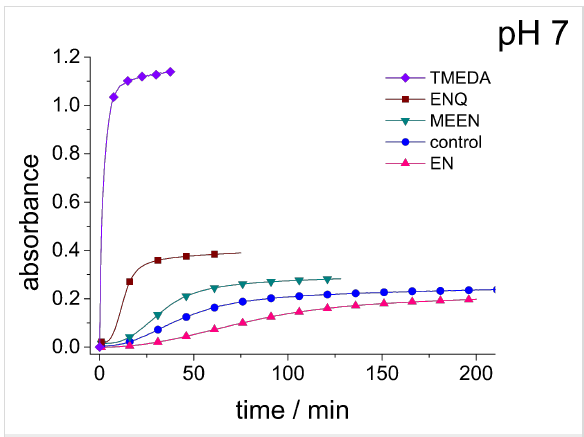
Figure 6: Absorbance of a 90 mM sodium metasilicate solution with 10 mM TMEDA, ENQ, MEEN, and EN (cf. Table 1) and of a pure sodium metasilicate solution (control, blue circles) measured as a func- tion of time up to 800 min.